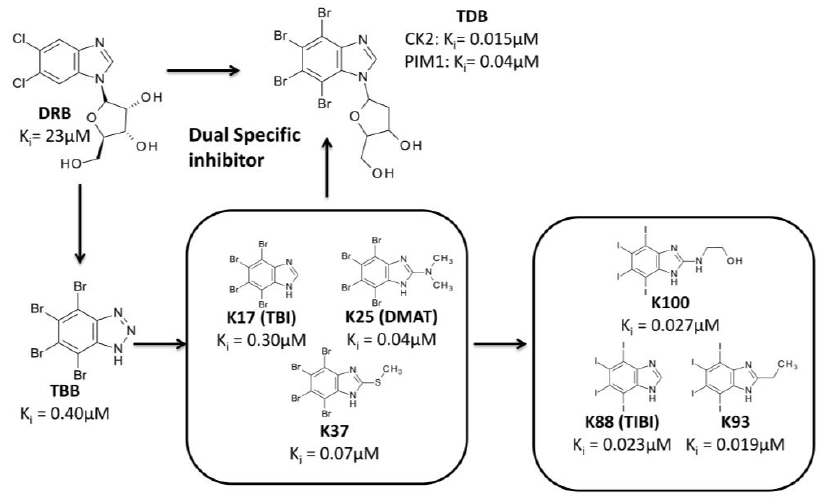
Figure 6. Schematic representation of the optimization of tetrabromobenzimidazoles.